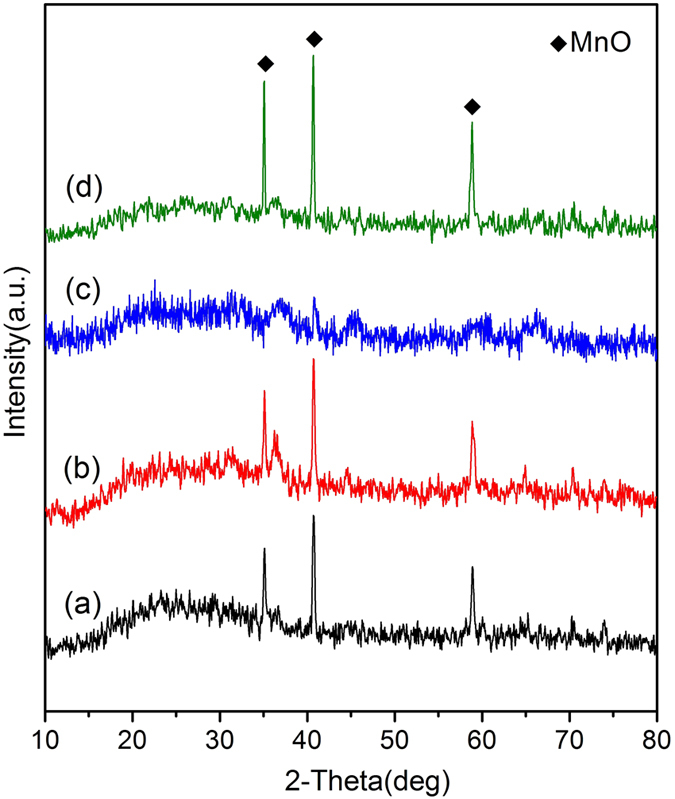
Corresponding XRD patterns of Mn2O3/Al nanothermite membranes and Mn2O3/Al nanoparticle composites after DSC test: (a) 10 min, (b) 20 min, (c) 30 min, and (d) Mn2O3/Al nanoparticle composites.